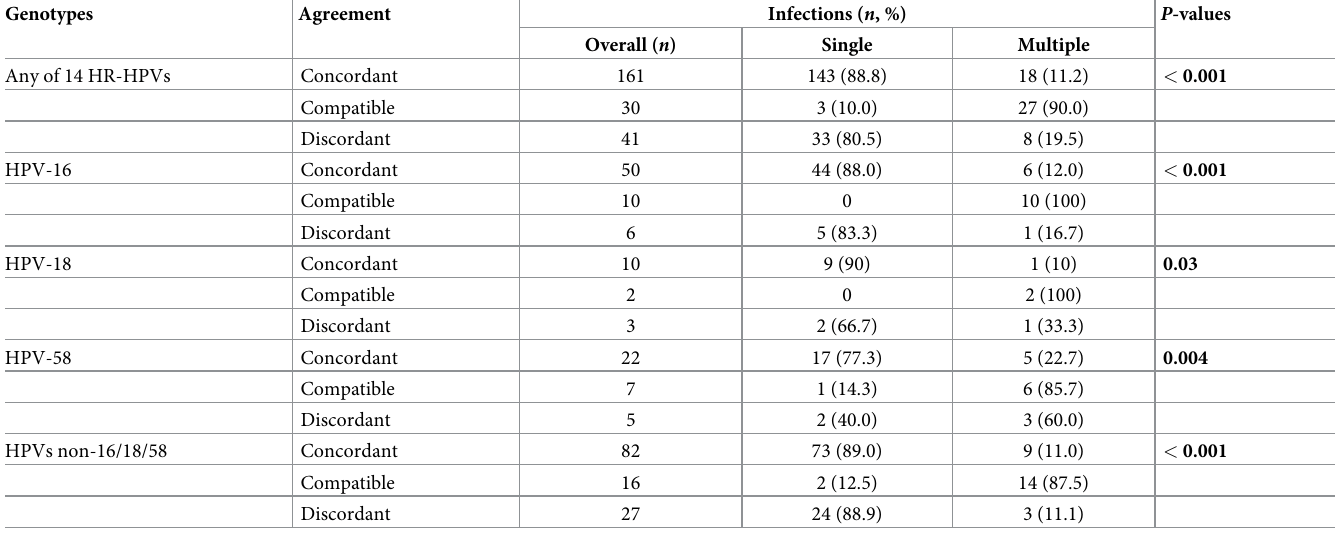
Table 3. Agreement of HPV chip tests for HR-HPV genotypes according to direct sequencing.